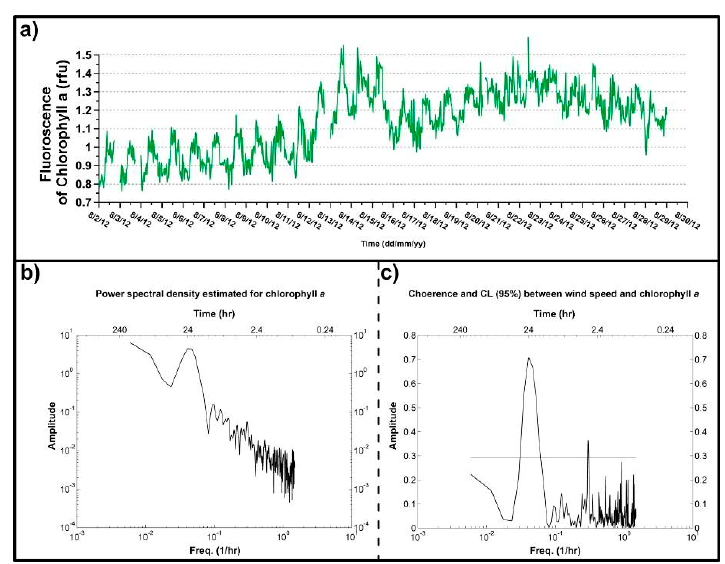
Figure 3. ( a ) Time-series of chlorophyll a between 2 August 2012 and 29 August 2012 recorded by oceanographic buoy (St. 1). ( b ) Power spectral density performed on chlorophyll a and ( c ) coherence between chlorophyll a and wind speed. Water 2018 , 10 , x FOR PEER REVIEW